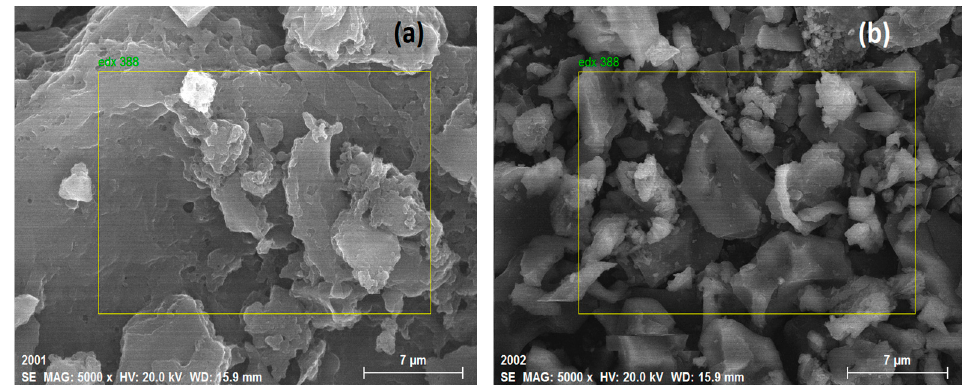
Figure 12. SEM images of XSBLAC before ( a ) and after ( b ) adsorption of zinc(II).